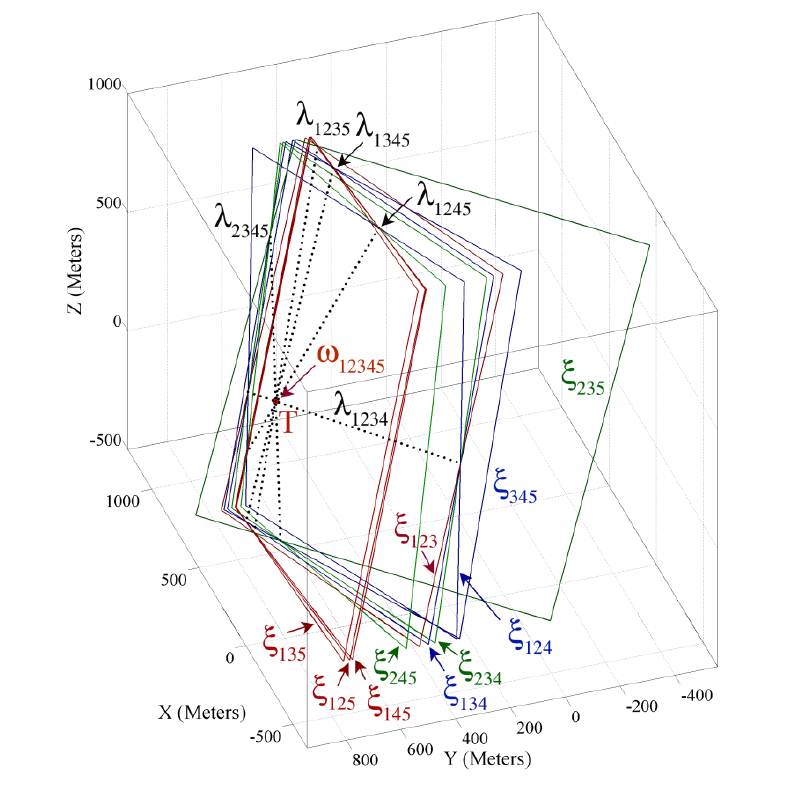
Figure 10. Ten axis planes and five axis lines of their bundle of hyperplanes and their extent point of five sensing